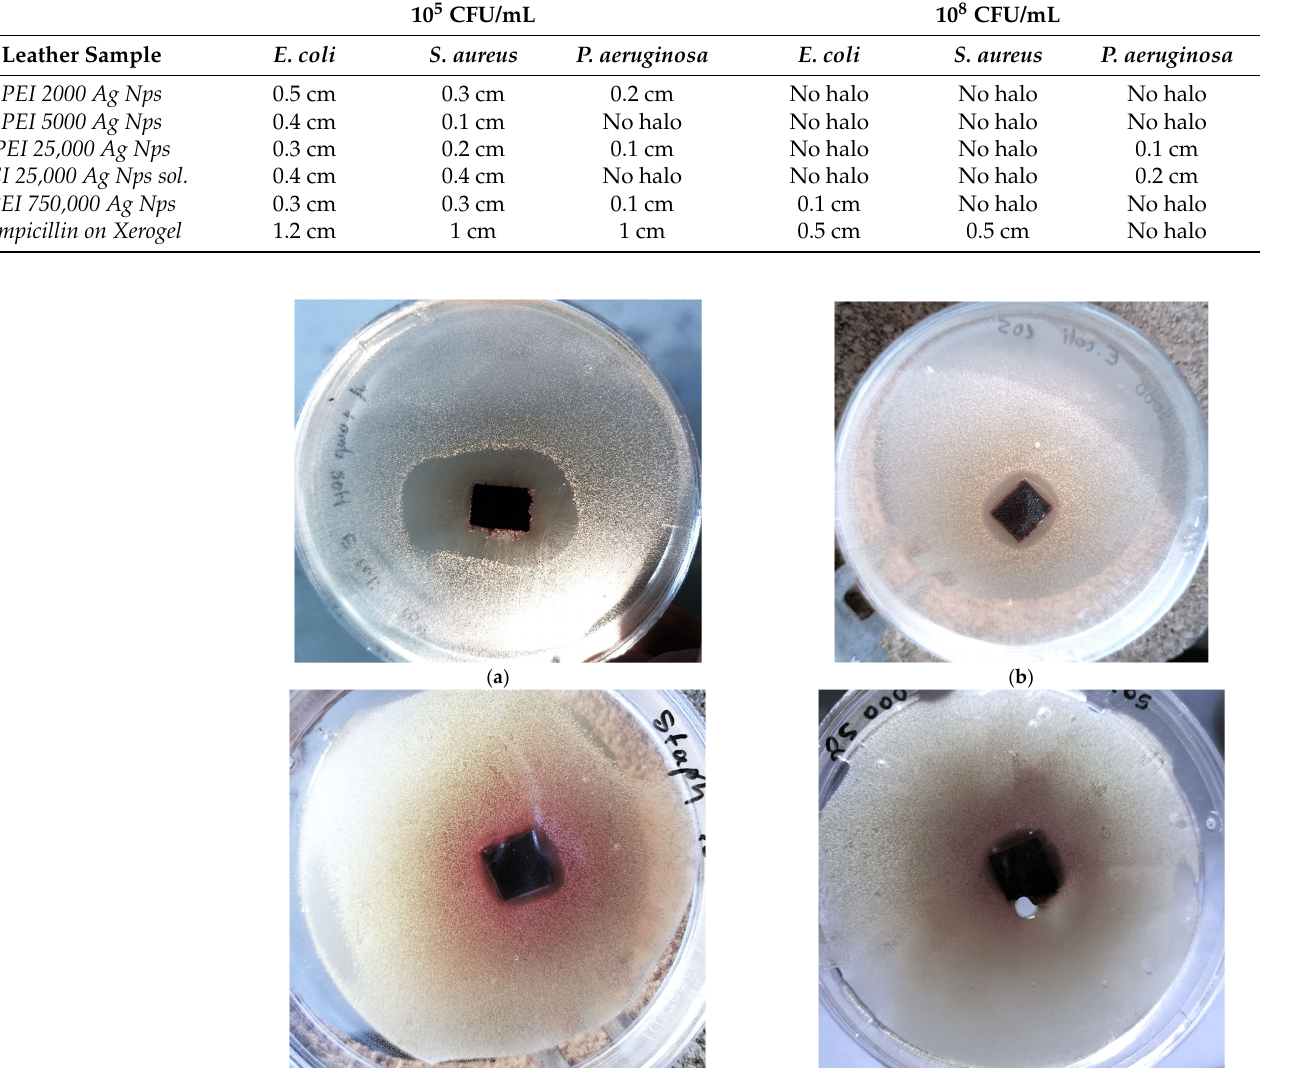
Table 2. The extent of propagation inhibition of Escherichia coli ATCC 25922, Pseudomonas aeruginosa ATCC 27853, and Staphylococcus aureus ATCC 29213 in the presence of treated leather samples. 10 5 CFU/mL 10 8 CFU/mL